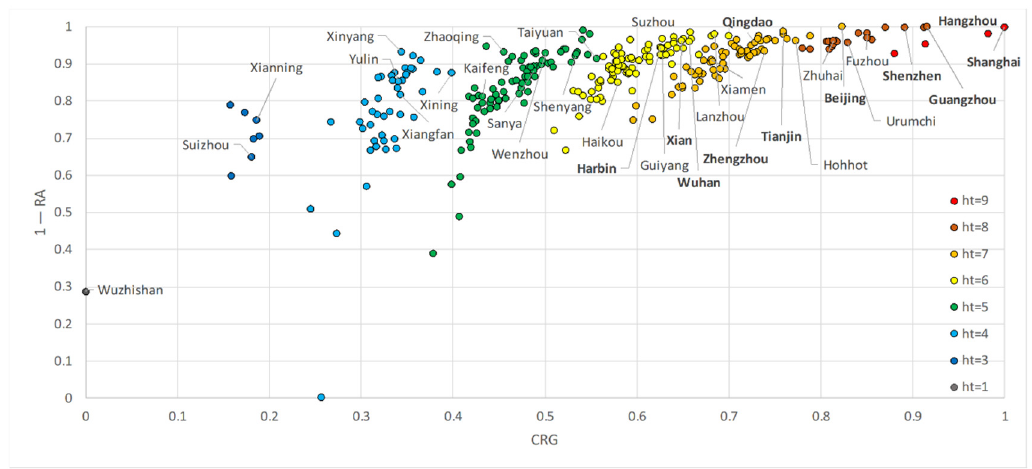
Figure 6. (Color online) An integrated view of CRG and RA of street connectivities for 298 cities. (Note: names of top cities by GDP are in bold).